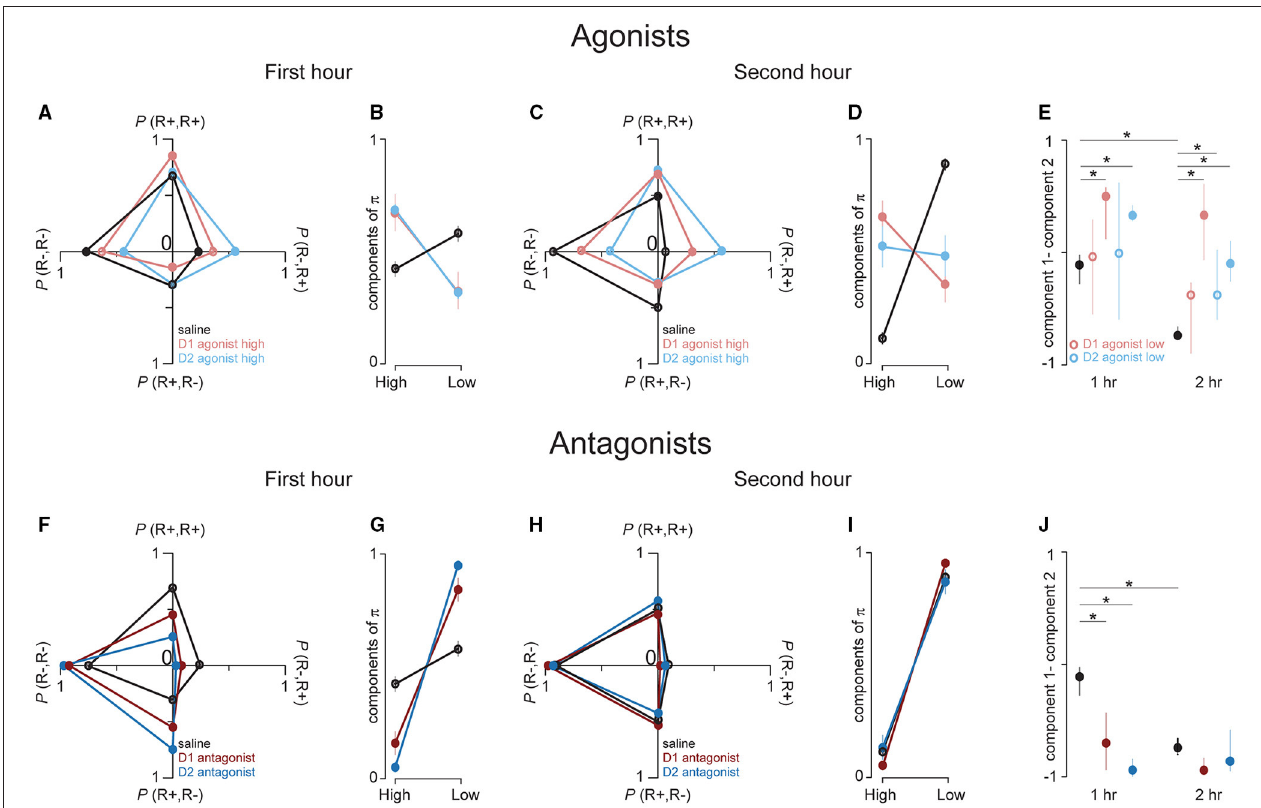
FIGURE 4 | D1 and D2 receptor agonists promote transistions from the non-responsive to responsive state. (A,C,F,H). These graphs show the associated transition probabilities for all 4 possible response/no response pairs, calculated with the equation given in the legend to Figure 3 . (A) The dots represent the transition probabilities in the first hour of behavioral testing for saline (black), high dose D1 agonist (red) and high dose D2 agonist (blue) treated rats. Note that in this first hour there is a very high probability of responding to a cue if the rat responded to the previous cue; this is indicative of response clustering. (B) The dots represent the cross-session mean of the components of the probability vectors calculated from the transition matrices that compose the mean probabilities in (A) . The two components give a steady state estimate of the probability of the rats being in the high (“High,” left dots) and low (“Low” right dots) responsive state, respectively. D1 agonist data is almost completely obscured by the D2 agonist data. (C,D) This data comes from the same sessions as in (A,B) , but the data is taken from the second hour of testing. (E) Dot plots show the median and middle quartiles of the differences between the two components of the probability vectors that are shown in (B) (left set of dot plots) and (D) (right dot plots). Filled symbols represent saline and high agonist doses. Open symbols represent low agonist doses (corresponding data in (A–D) are not shown for low doses). (F–J) Same plotting conventions as in (A–E) , but these figures show data from the first (F,G) and second hour (H,I) after saline (black), D1 antagonist (dark red) and D2 antagonist (dark blue) injections. * p < 0.05.